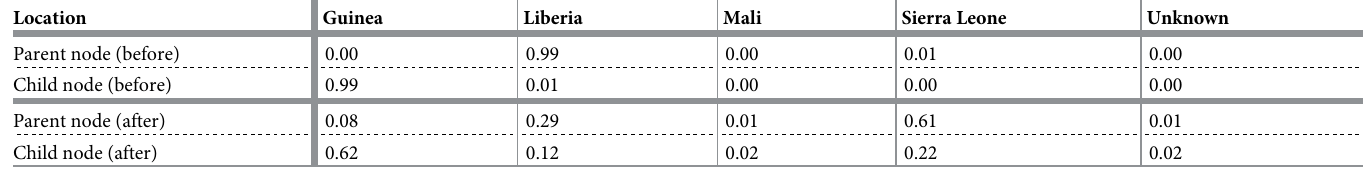
Table 2. Effect of downsampling on inferred introduction events. Likelihood of the parent node and the child node of a migration event in the gray box being at each location before and after downsampling recent